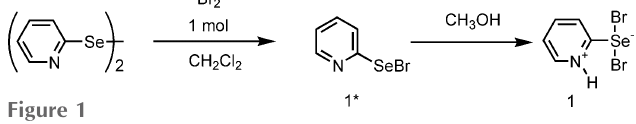
Figure 1 Synthesis of 1 H -pyridine-2-selenenyl dibromide 1 by the bromination of bis(pyridin-2-yl) diselenide in methylene